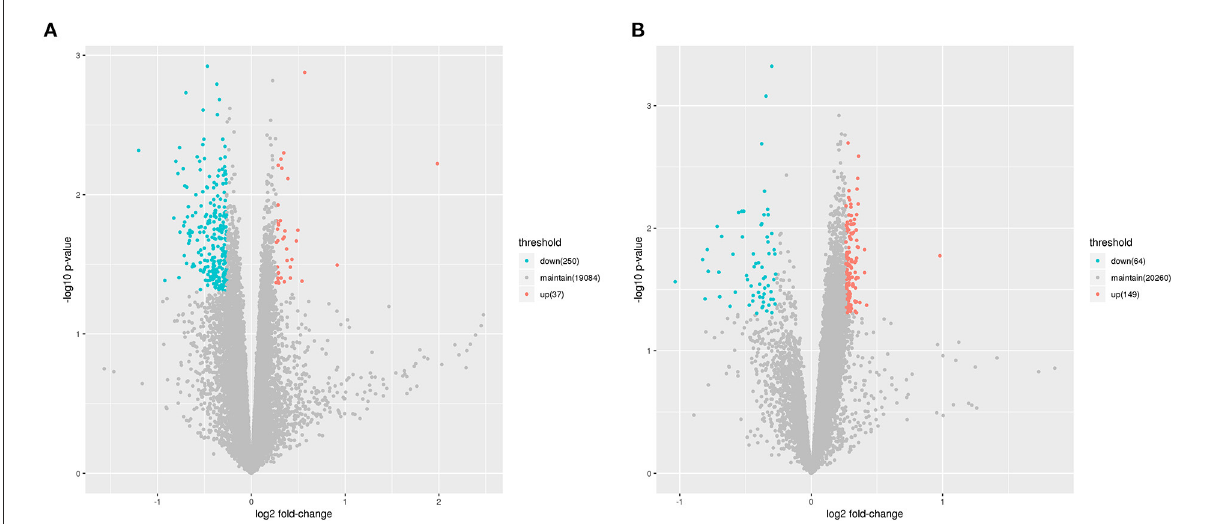
FIGURE1 The Volcano Plot showing the variation of lncRNA (A) and mRNA (B) expressions. The red points indicate up-regulated genes (Fold change > 1.2), and green points indicate down-regulated genes (Fold change < 0.83).